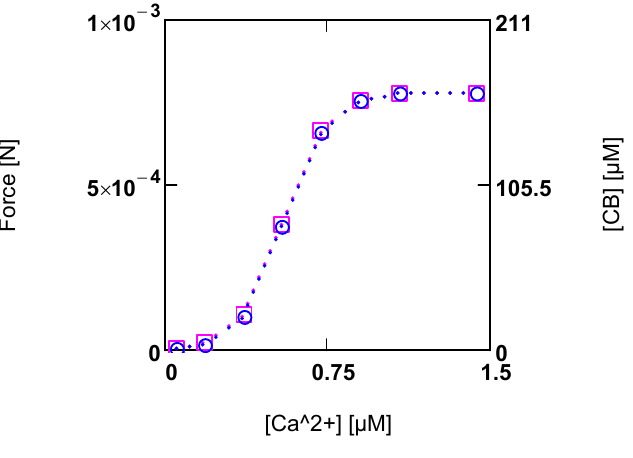
Figure 4. Developed force and cross-bridge concentration [CB] and their dependence on [Ca 2+ ]. (red squares) force; (blue circles) [CB]. Notice that at the given dimensioning of the right ordinate a matching of results is